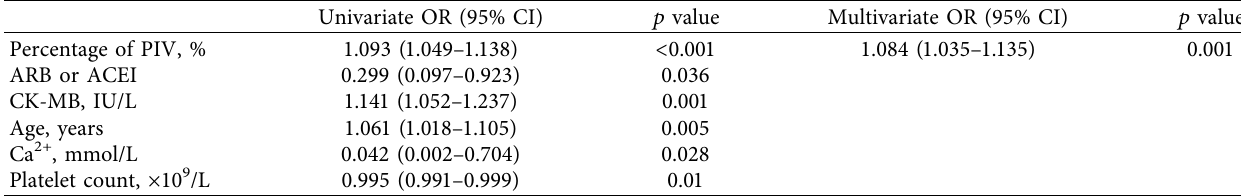
Table 6: Univariate and multivariate logistic regression analysis of more severe patients with COVID-19 and